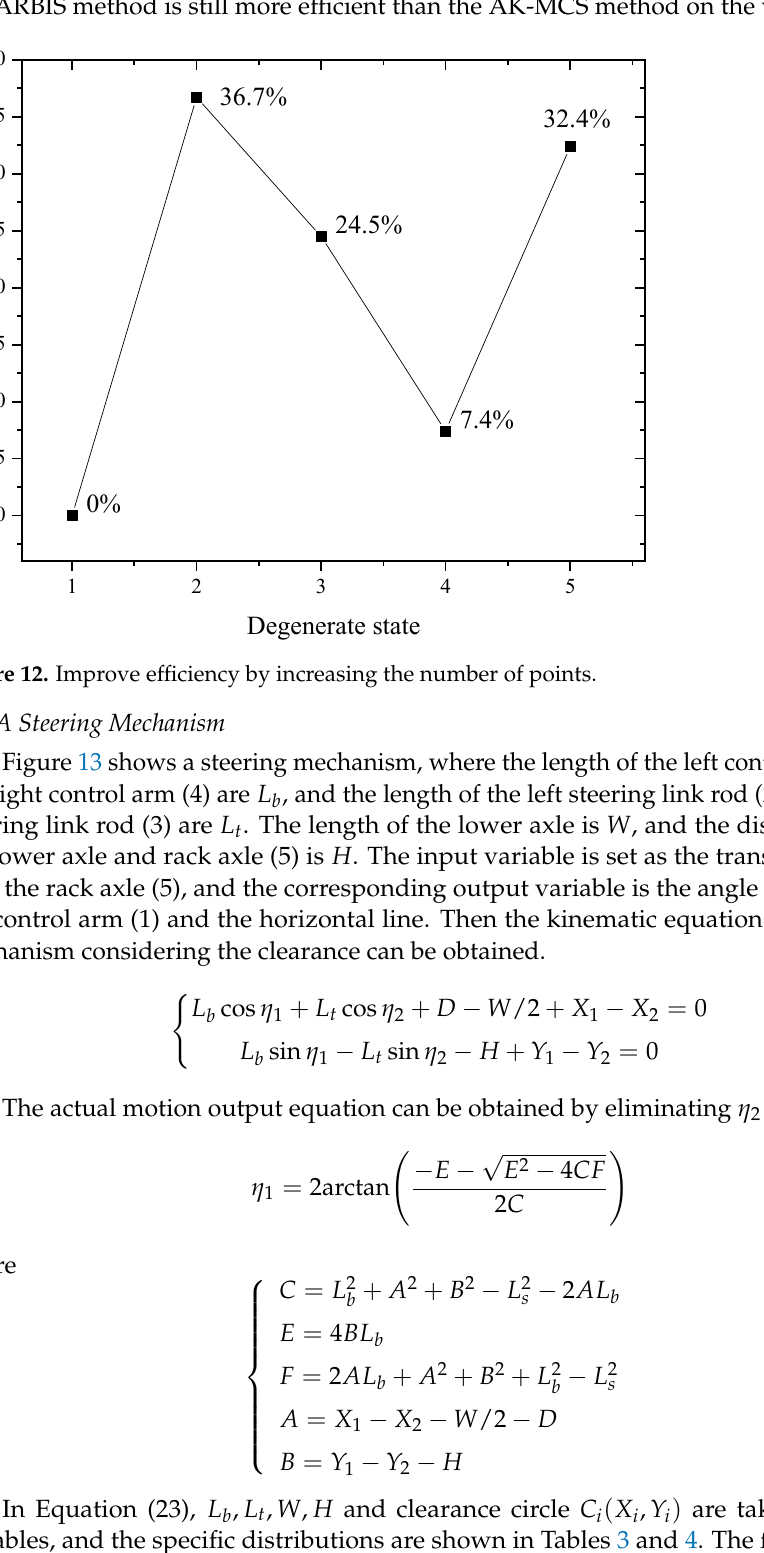
15 of 22 Table 2. Calculation results of a four-bar linkage mechanism. Methods